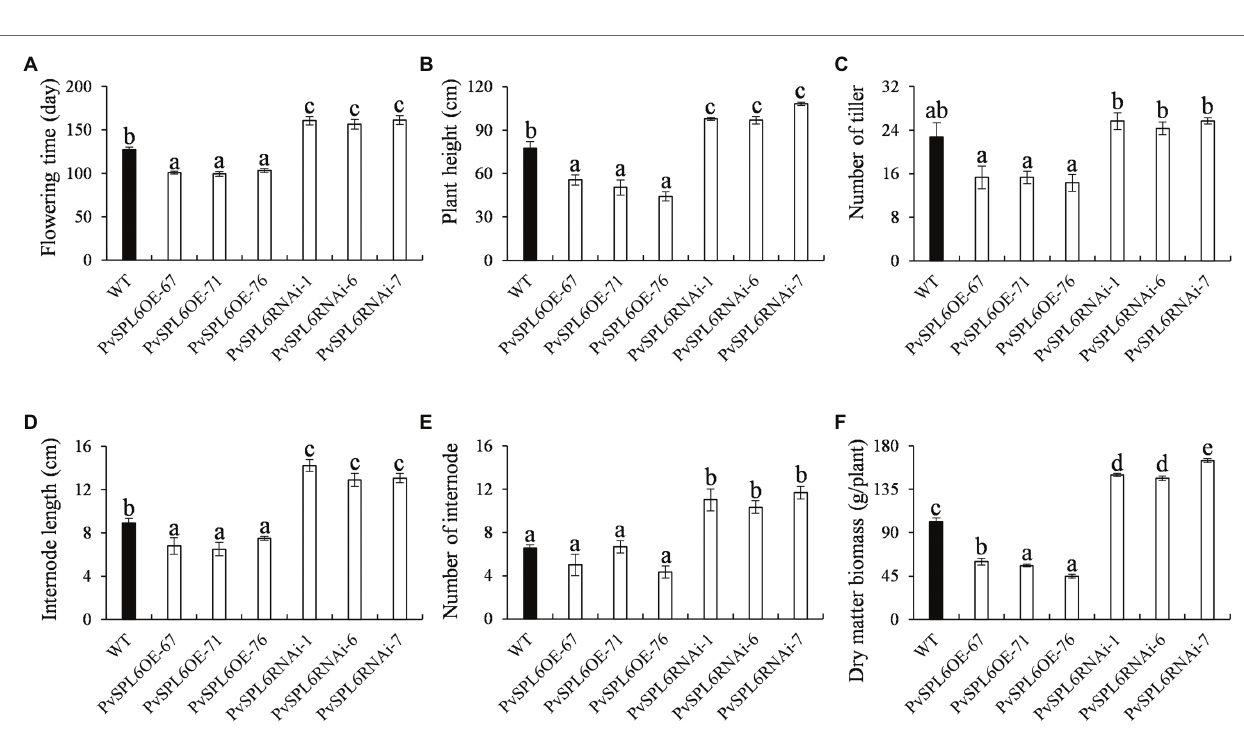
FIGURE 5 | Phenotypic statistics of PvSPL6 OE and PvSPL6 RNAi transgenic switchgrass plants. Comparisons of (A) flowering time, (B) plant height, (C) number of tiller, (D) internode length, (E) number of internode, and (F) dry matter biomass. The values are the means ± SEs ( n = 3). The letters above the error bars indicate significant differences determined by one-way ANOVA ( p < 0.05, Duncan’s multiple-range